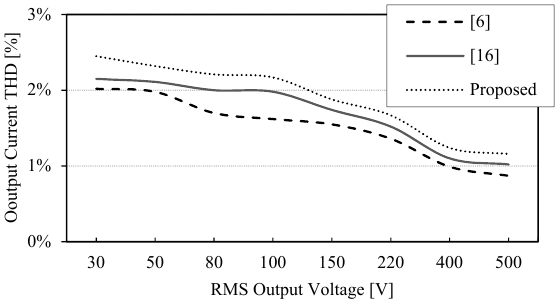
Figure 16. Output current THD comparison as a function of output AC voltage.